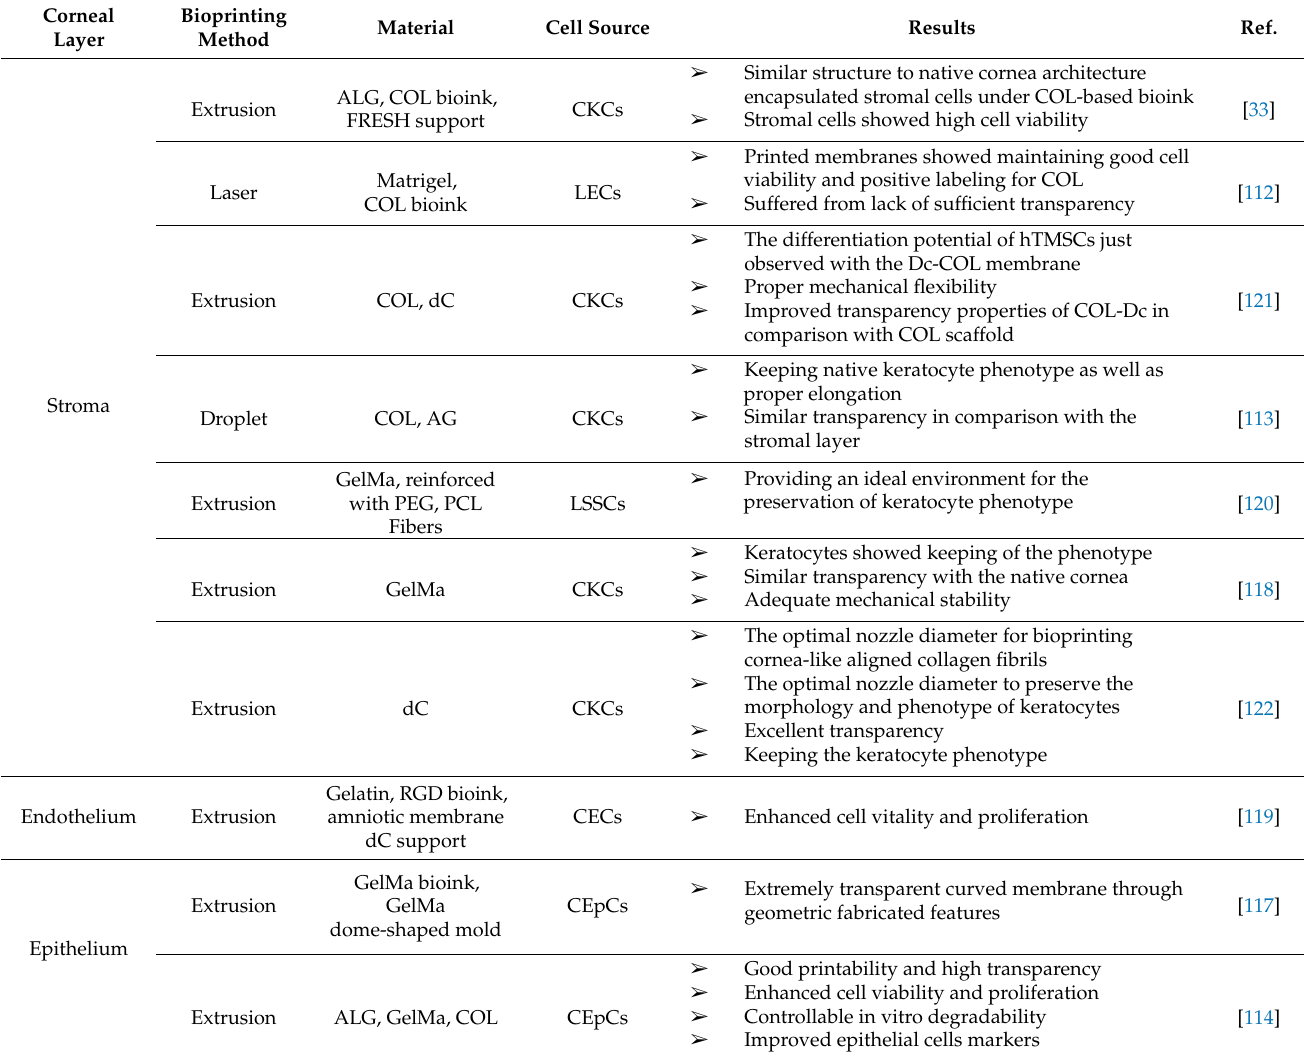
Table 1. Summary of different experimental studies based on 3D printing